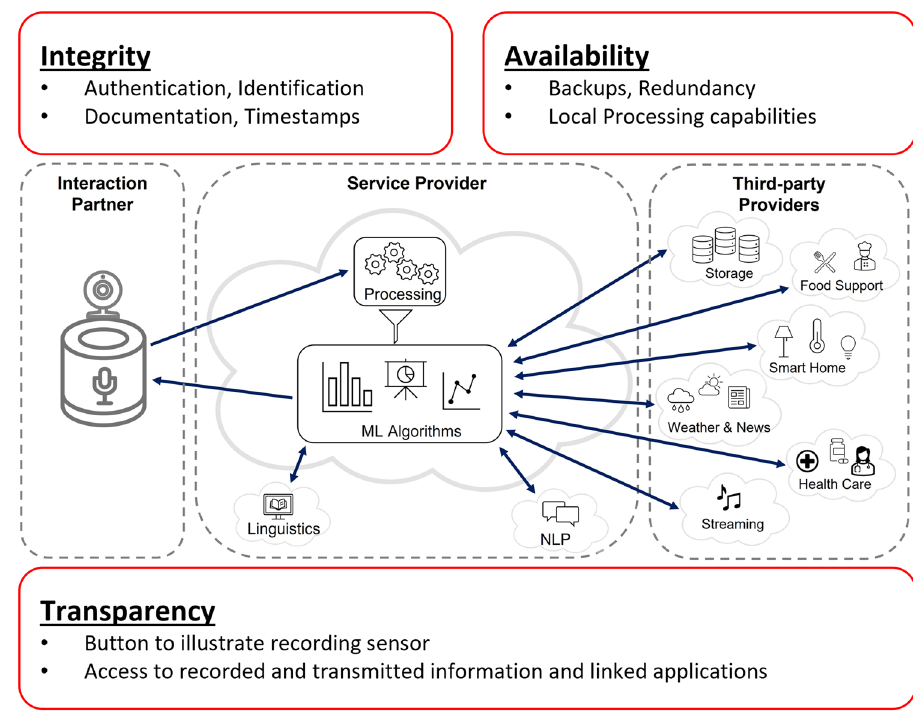
Figure 5: Mitigation strategies for respective interrelations in the context of